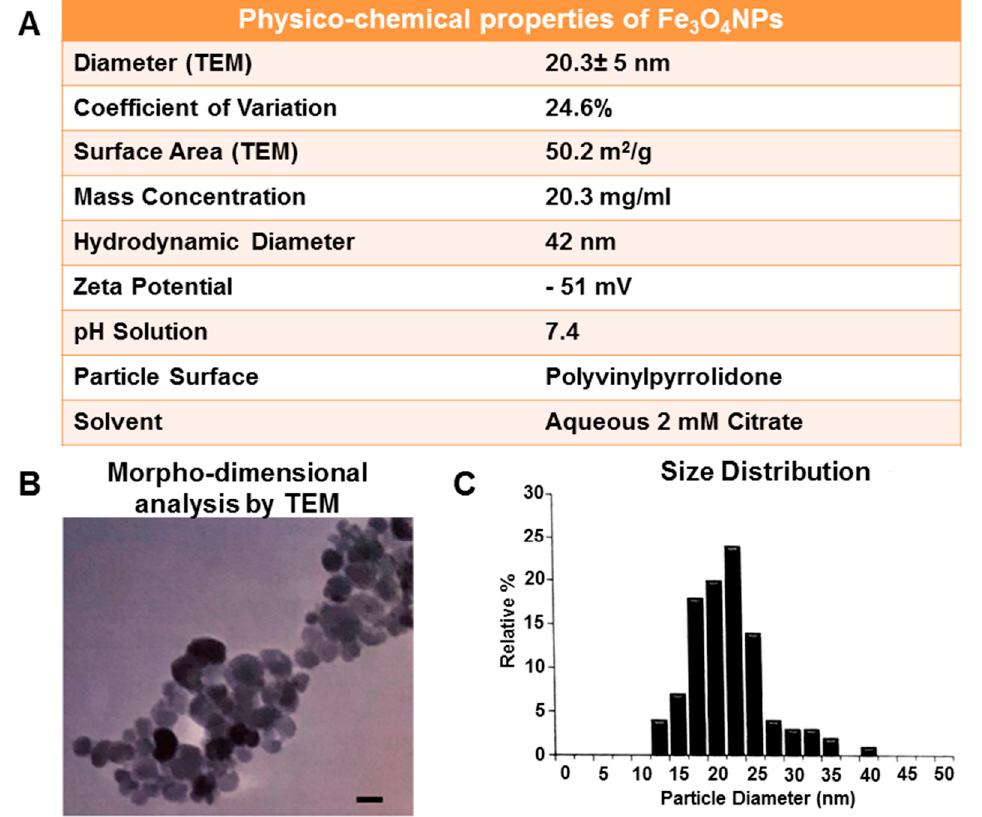
Figure 10. Physico-chemical properties of the Fe 3 O 4 NPs stock suspension in aqueous 2 mM citrate ( A ). Morpho-dimensional analysis of Fe 3 O 4 NPs stock suspension by TEM indicates roughly spherical almost non-agglomerated particles. Scale bar: 20 nm ( B ). Size distribution by dynamic light scattering measurements shows an average diameter of 20.3 ± 5 nm ( C ). Data provided by the Company nanoComposix.